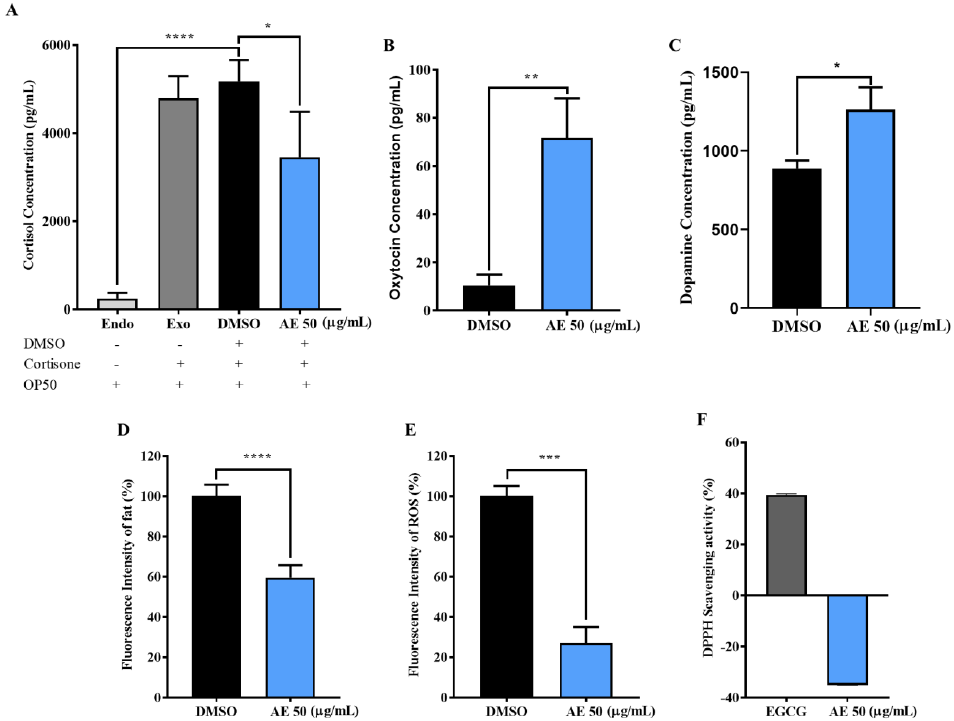
Figure 3. Effect of AE treatment on stress biomarkers in wild type C. elegans . Worms were cultured at 20 °C on NGM-OP50 plates, treated with or without AE (50 µg/mL) for 96 h. ( A ) Cortisol production was assessed through the 11 beta hydroxysteroid dehydrogenase pathway and its quantity in worm homogenate determined by ELISA ( n ≈ 3000 worms ). Statistical differences compared to control (DMSO) were considered significant at * p < 0.05, **** p < 0.0001 by one-way ANOVA. Endo represents endogenous cortisol production. Exo represents exogenous cortisol production (cortisone addition). ( B ) Oxytocin levels in worm homogenate were quantified by ELISA ( n ≈ 3000 worms), ( C ) Dopamine levels in worm homogenate were quantified by ELISA ( n ≈ 3000 worms ), ( D ) Fat accumulation was determined by Nile red staining ( n = 10 worms/group), ( E ) Intracellular ROS accumulation was determined by DCFHDA assay after 1 hr incubation time ( n = 20 worms/group) and ( F ) In vitro ROS determination by DPPH assay after 30 min incubation time. Statistical differences compared to control (DMSO) were considered significant at * p < 0.05, ** p < 0.01, *** p < 0.005 and **** p < 0.0001 by Student’s t -test. Data were represented as mean ± SD. Experiments were performed in triplicate